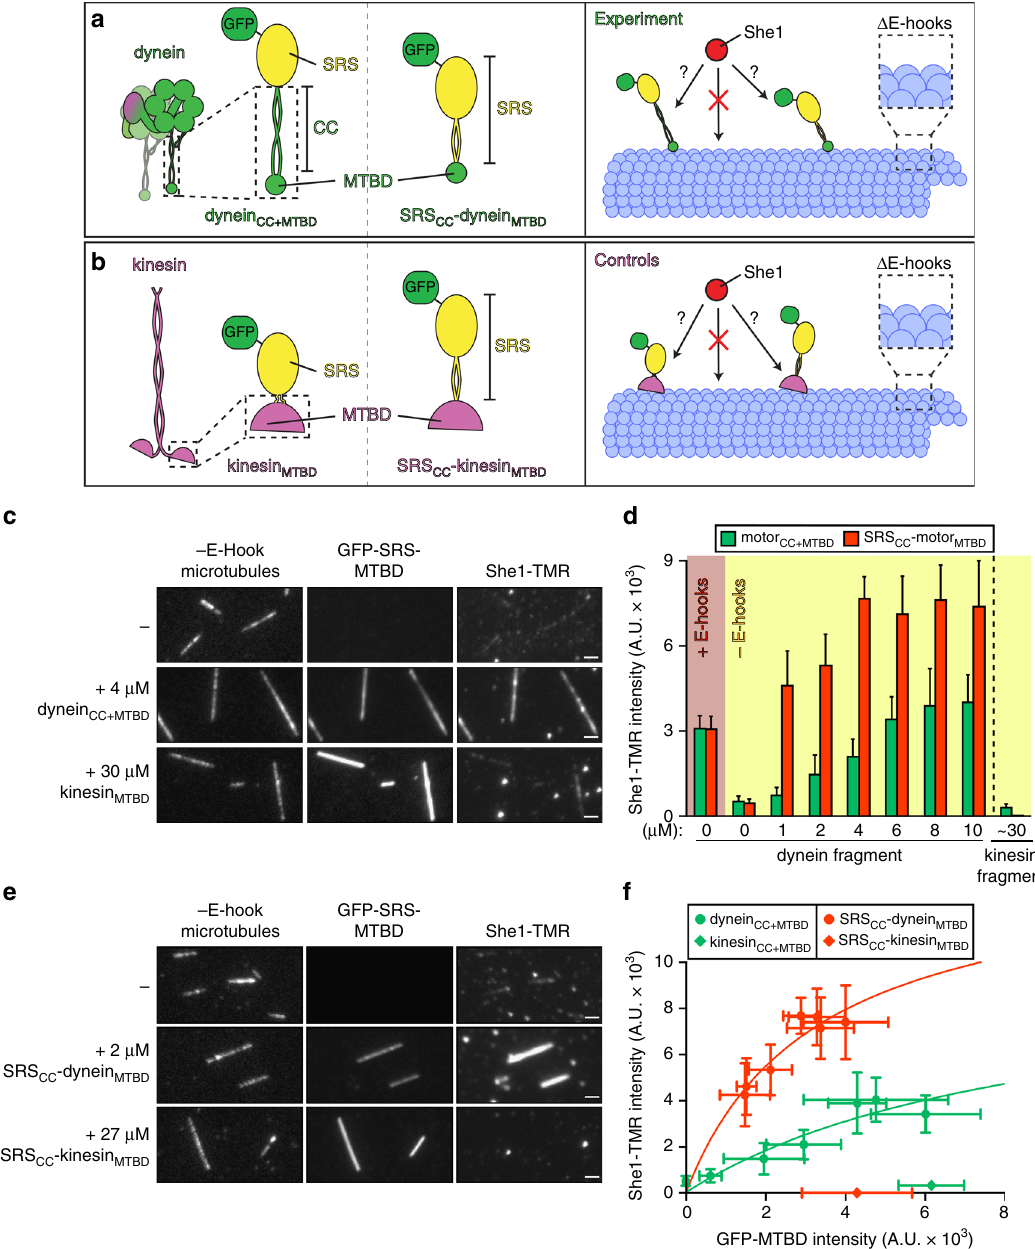
Fig. 5 She1 binds directly to the dynein microtubule-binding domain. a – b Cartoon representations of the various GFP – seryl tRNA synthetase (SRS) – dynein ( a ) and kinesin ( b ) fusions used in the microtubule recruitment assays (left) along with a schematic of the experimental setup (right). The SRS globular domain fused to either the dynein coiled coil (CC) and microtubule-binding domain (MTBD), or the kinesin MTBD, respectively are depicted in a and b , left, while a and b , middle, depict the SRS globular and coiled coil domains fused to either the dynein or kinesin MTBD domains, respectively. c , e Representative fl uorescence images of She1-TMR recruitment to subtilisin-digested microtubules by GFP – SRS – dynein – SRS – SRS – dynein CC+MTBD ( c ) or GFP CC MTBD ( e ), but not the respective kinesin MTBD controls. Respective images acquired from each experiment are displayed with identical brightness and contrast levels. Note that in spite of the lesser degree of microtubule-binding by the SRS CC – dynein MTBD fusion (in e ) compared to dynein CC+MTBD (in c ), more She1-TMR is recruited to microtubules by the former (scale bars, 2 µ m). d Quantitation of the extent of She1-TMR recruitment to subtilisin-digested microtubules by increasing concentrations of the indicated GFP – SRS – MTBD fusion (error bars, standard deviation; n ≥ 19 microtubules, and ≥ 82 µ m of MT length for each condition). f Relative recruitment of She1-TMR by indicated GFP – SRS – MTBD fusion. Different points re fl ect the mean fl uorescence intensity values (along with standard deviations) for She1-TMR ( fi xed at 20 nM) vs. increasing concentrations of indicated GFP – SRS – MTBD fusions. Note that concentrations of the kinesin MTBD fusions were chosen such that the degree of their microtubule binding closely matched the maximal microtubule binding by the corresponding dynein fragment. As in Fig. 4e, the extent of She1-TMR microtubule recruitment was directly compared to relative microtubule binding by each GFP – SRS – MTBD fragment; Supplementary Fig.